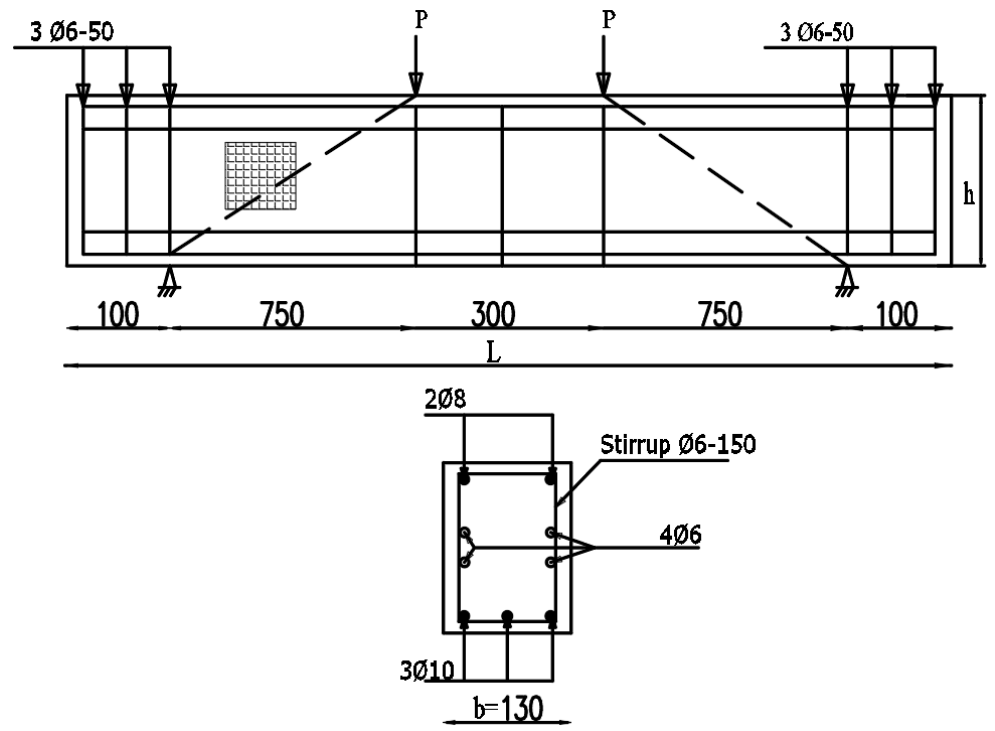
Figure 3. Arrangement of the reinforcement in the tested deep beams (All units in mm).